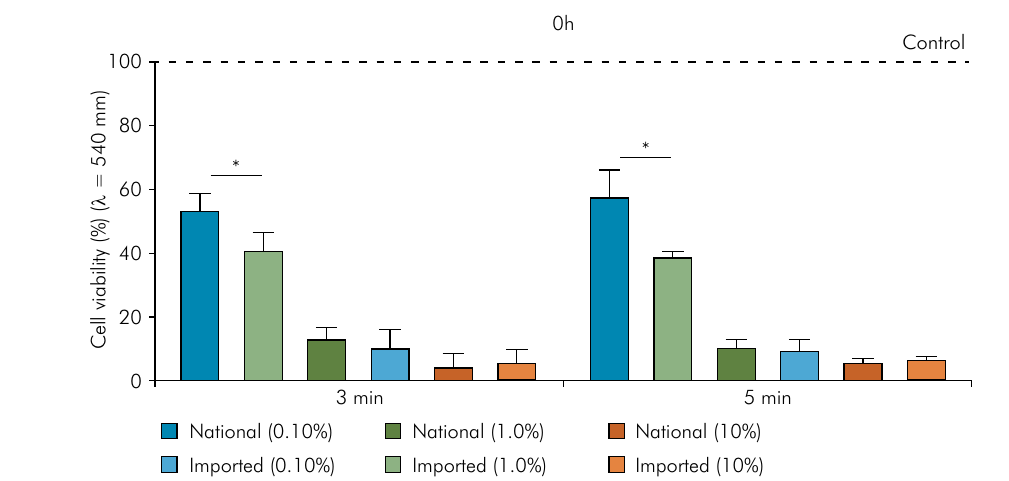
Figure 1. MTT assay immediately (T0) after exposure of cell cultures to the different CSs diluted up to a concentration of 10%, comparing both NCS and